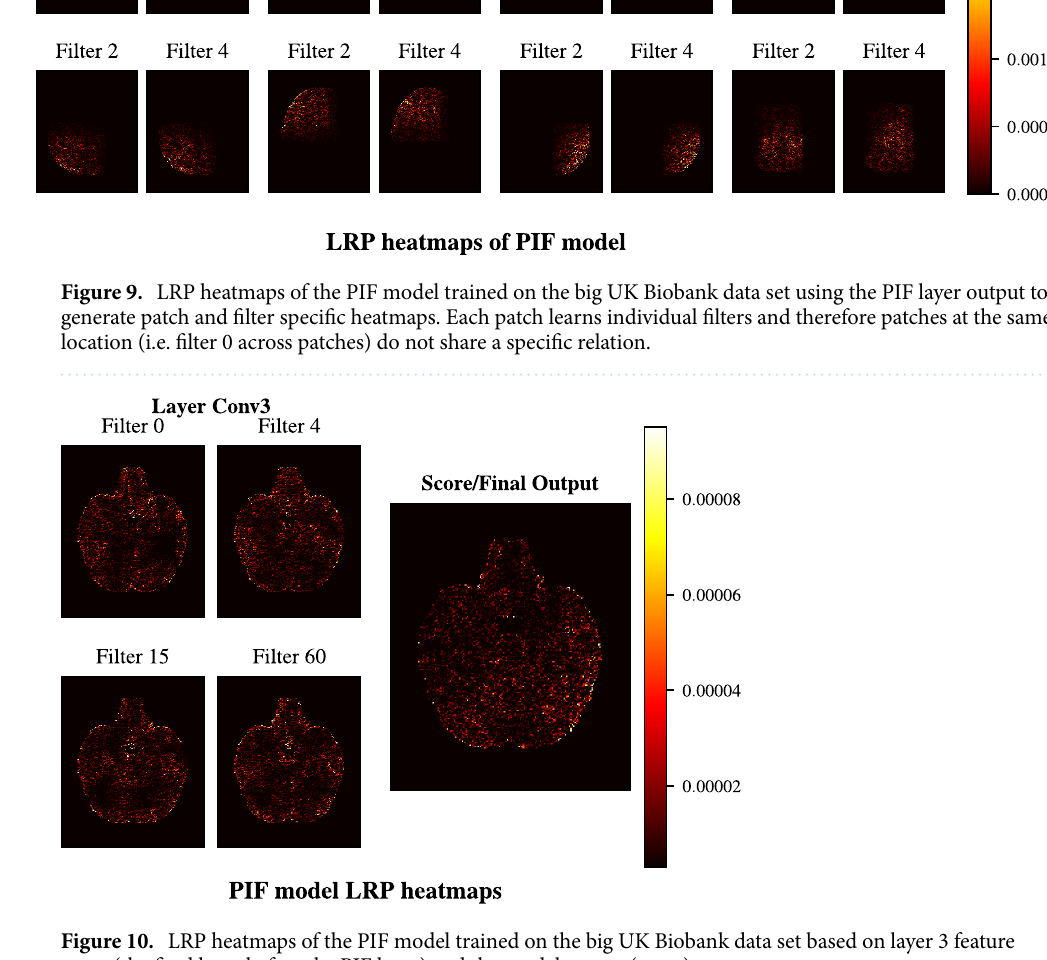
Figure 10. LRP heatmaps of the PIF model trained on the big UK Biobank data set based on layer 3 feature maps (the final layer before the PIF layer) and the model output